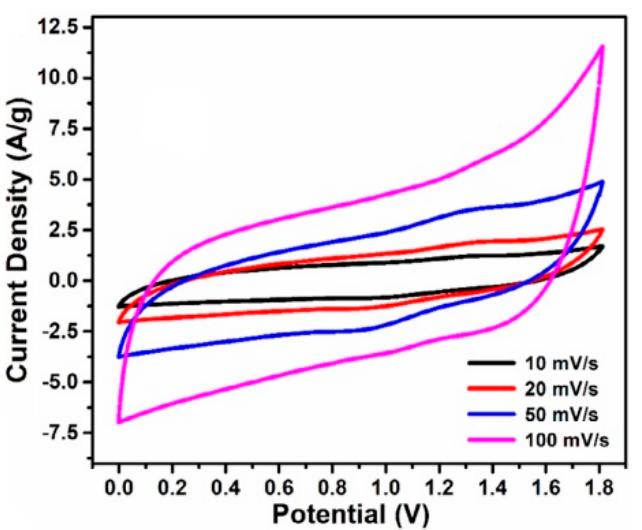
Figure 8. Cyclic voltammograms of ACs/TiO 2 composite electrodes at different scan rates and 1 M H 2 SO 4 electrolyte. Reprinted with permission from [92]. Copyright Wiley (2020). H 2 SO 4 electrolyte. Reprinted with permission from [92]. Copyright Wiley